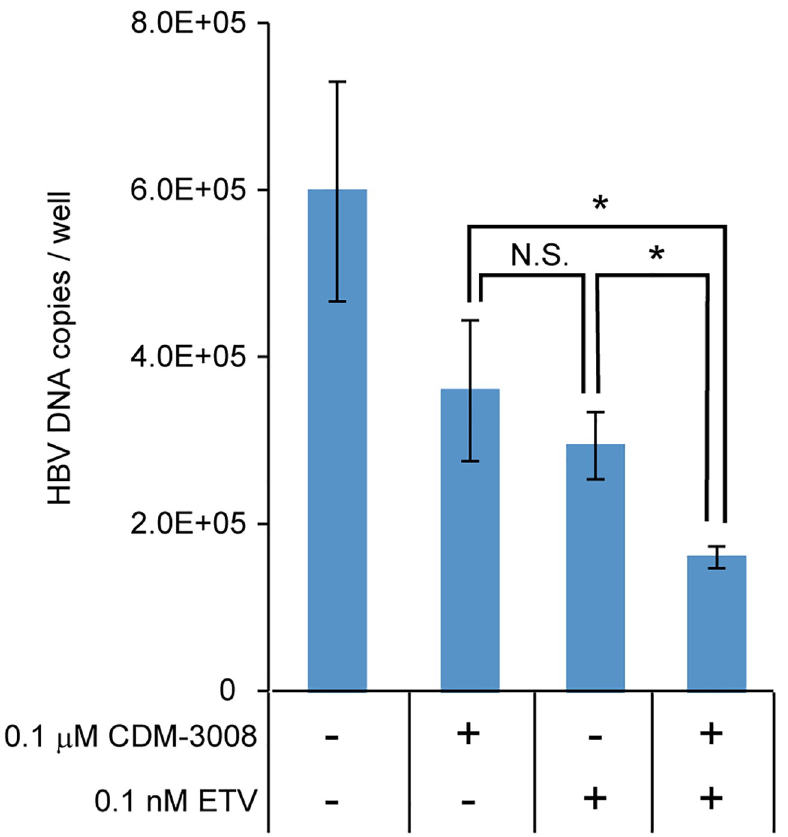
Fig 10. Additive effect of CDM-3008 and entecavir on anti-HBV activity. Primary cultured human hepatocytes (PXB cells) were infected with HBV genotype C for 1day and cultured for 28 days; the cells were then treated with 0.1 μ M CDM-3008 and/or 0.1 nM entecavir (ETV) for 7 days. HBV DNA copies in PXB cells were measured by qPCR. The error bars indicate S.D. (n = 3). � , p < 0.05 (two-tailed t -test).